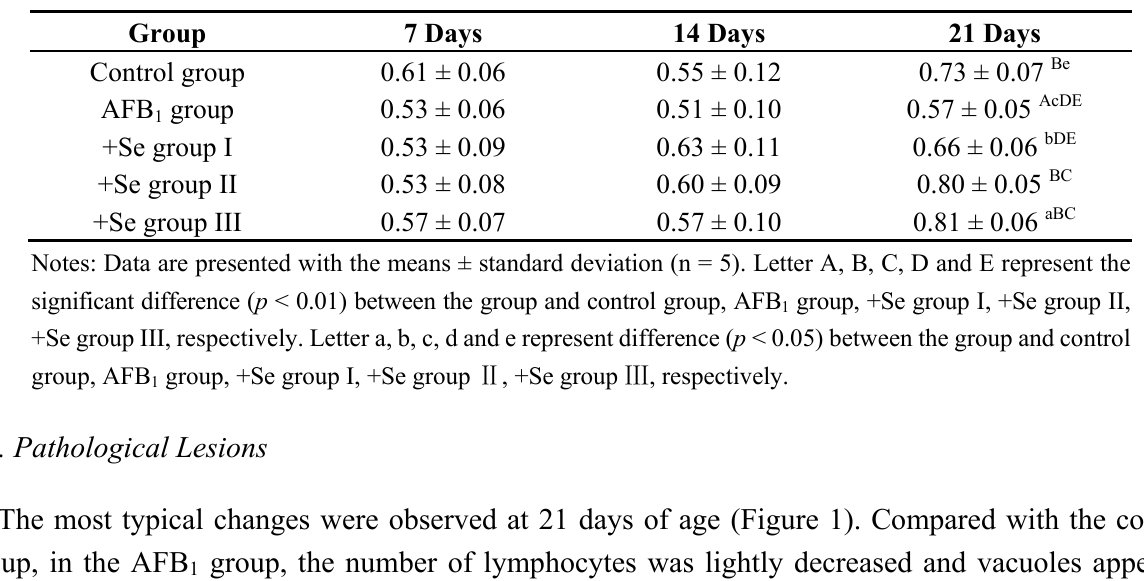
Table 1. Relative Weight of Spleen Changes